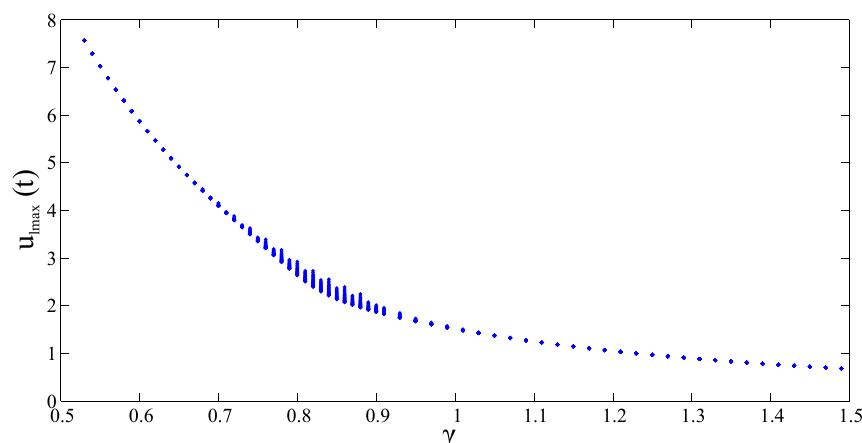
Figure 7. Bifurcation diagram for an unperturbed system τ(t) = 0, bifurcation parameter γ versus local maximum of time series u lmax (t) , and (cid:53) = ( 0 . 25 , 0 . 8 ,γ) .